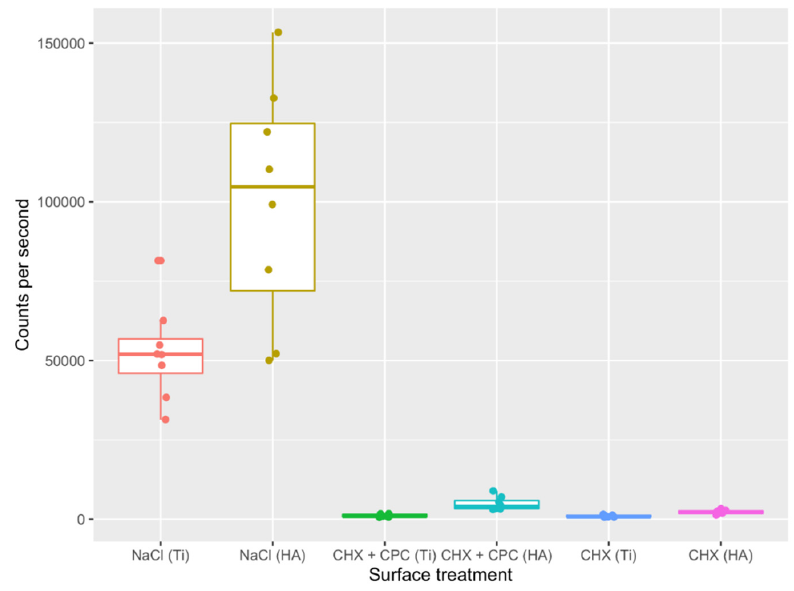
Figure 1. Bacteria viability after 24 h of in situ plaque collection and treatment with NaCl, CHX + CPC or CHX at two types of surfaces (i.e., Ti and HA).